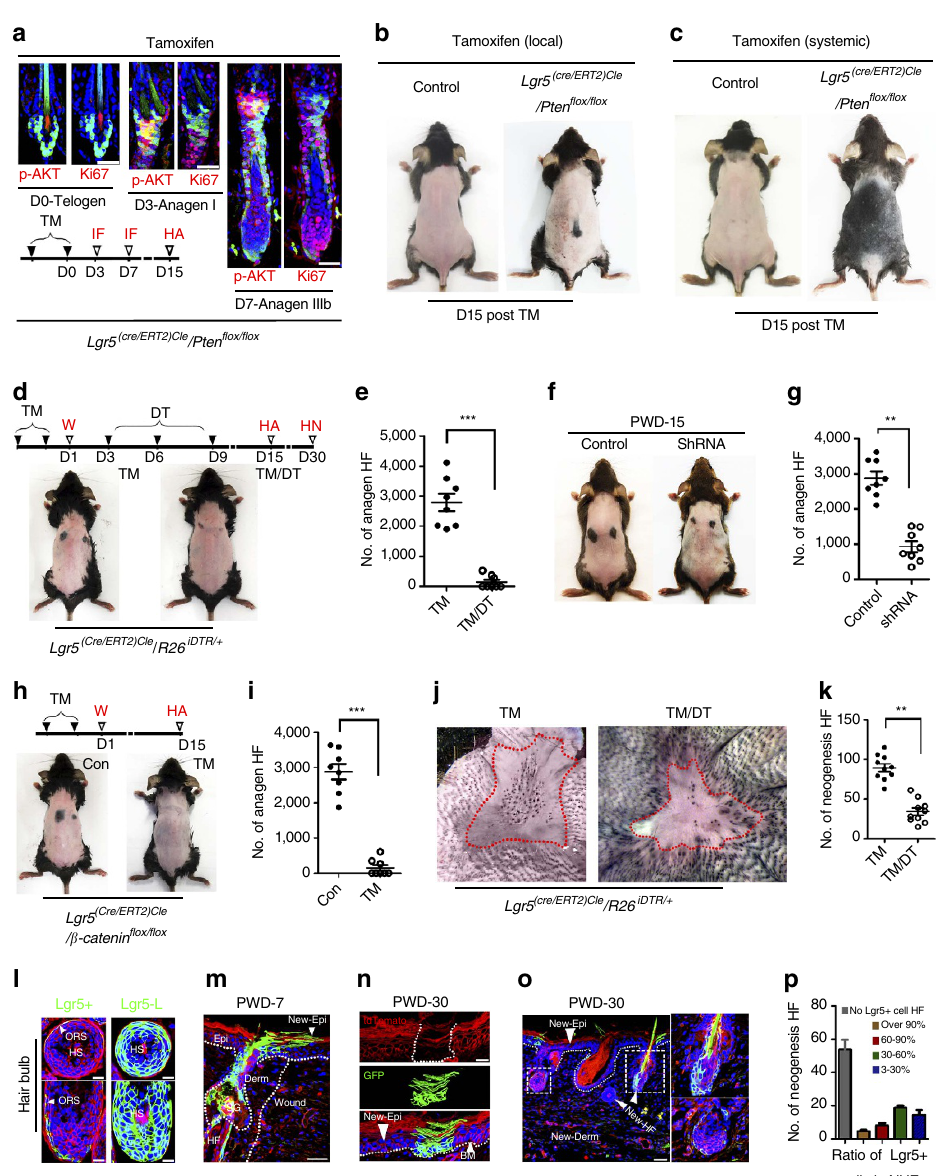
Figure 5 | Lgr5 þ HFSCs are indispensable for WIH-A and important for WIHN. ( a ) IF analysis of skin tissue sections indicated that tamoxifen treatment for Lgr5-Cre:Pten flox/flox mice induced marked p-AKT and the division of Lgr5-EGFP þ cells in the HF. Scale bars, 50 m m. ( b ) Subcutaneous injection of tamoxifen induced HF TATat the injection site in Lgr5-Cre:Pten flox/flox mice ( n ¼ 6). ( c ) Intraperitoneal administration of tamoxifen induced widespread HF TAT in back skin. Lgr5-Cre:Pten flox/flox mice, n ¼ 9; WT mice, n ¼ 12. ( d , e ) Deletion of Lgr5 þ cells in Lgr5-Cre:R26 iDTR/ þ mice completely attenuated the WIH-A ( d ), and the number of anagen HFs was quantified ( n ¼ 7) ( e ). ( f , g ) Wound-induced anagen HFs were markedly decreased in mice that